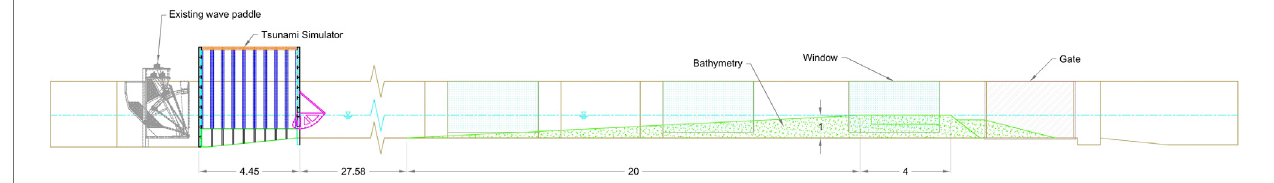
Frontiers in Built Environment |